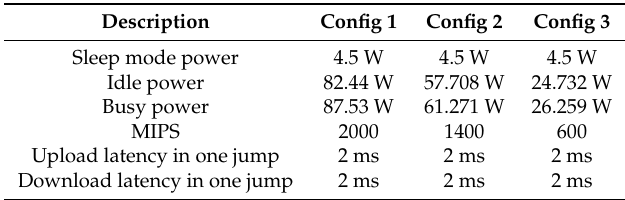
Table 2. Simulation